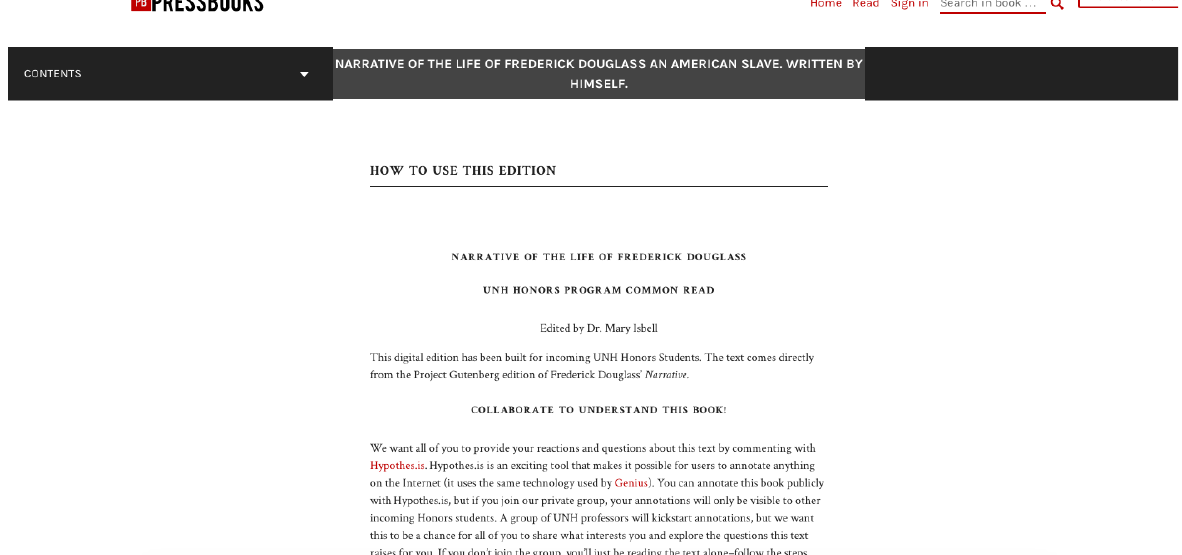
Figure 1. Landing Page for the 2016 Honors Program Common